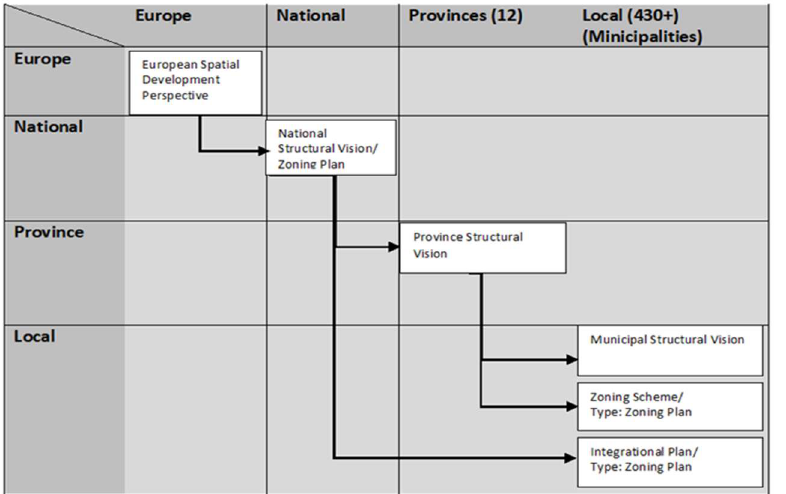
Figure 2. The Dutch spatial planning system: levels and instruments. Resources: Own compilation based on Schrenk, Neuschmind, and Wasserburger [16].